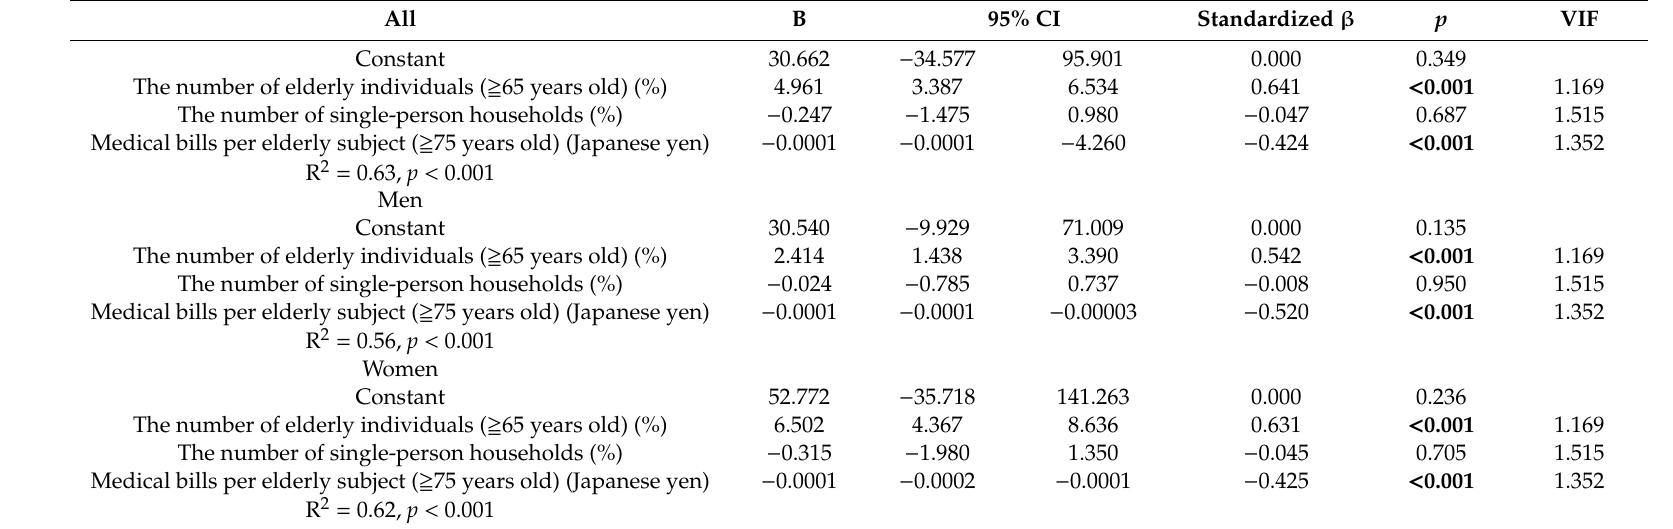
Table 4. Relationships between the number of deaths due to senility and socioeconomic factors by a multiple regression analysis.